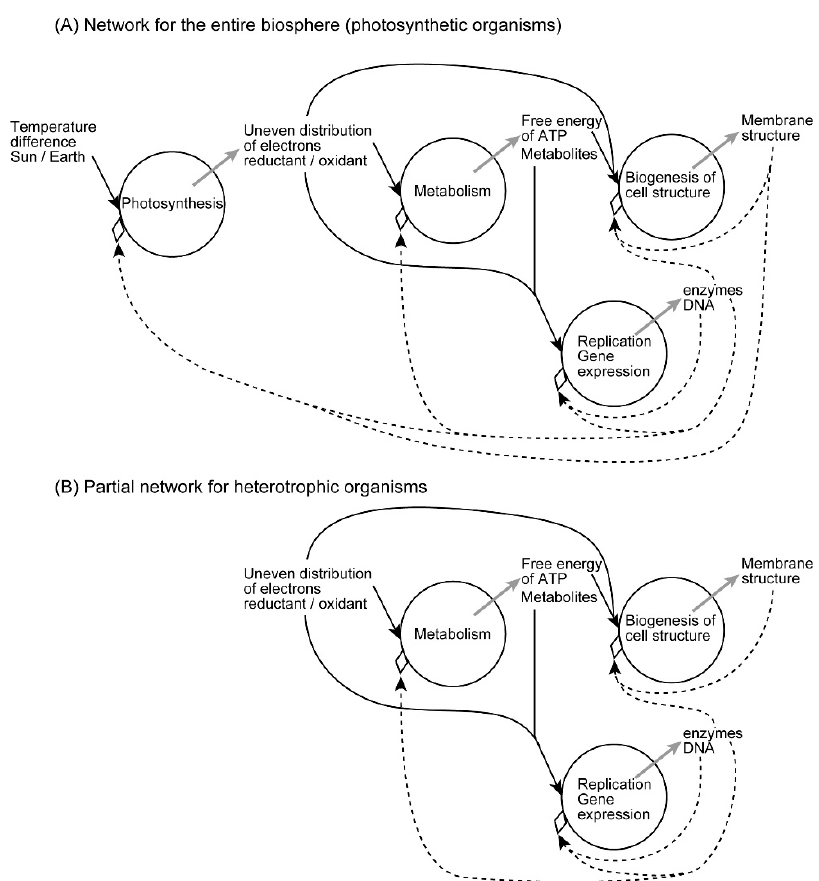
Figure 5. Hierarchy of the network of emergent processes in biological organization. ( A ) Network of the entire biosphere, valid also for photosynthetic organisms. ( B ) Network of heterotrophic organisms. Each circle represents an emergent process, in which one or more incoming inhomogeneities are shown by black arrows, whereas an emergent inhomogeneity is shown by a grey arrow. Inhomogeneities acting as constraints are shown by dashed arrows. Note that the constraints are not inhibitors. Rather, they also contribute to the emergence. In the entire biosphere, the ultimate driving force is provided by the sunlight, and various positive feedback loops enable self-organization of cell structure. The network is not closed within a single organism, but extends over the entire biosphere including various organisms. However, the constraints work only within a single cell or an organism. Heredity and evolution are not explicitly included in this scheme, which may be extended to include them as shown in [4]. The network in ( A ) is applied for the entire biosphere, but it is also valid for photosynthetic organisms, although excess reductants and oxygen are released for consumption by heterotrophs. In the partial network of heterotrophic organisms, incoming inhomogenetities are food and oxygen, which represent reductant and oxidant, respectively.